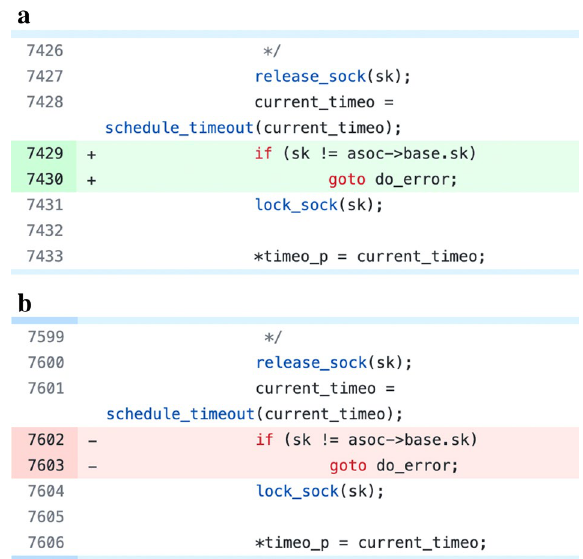
Fig. 1 Vul-inducing and Vul-fixing commits of